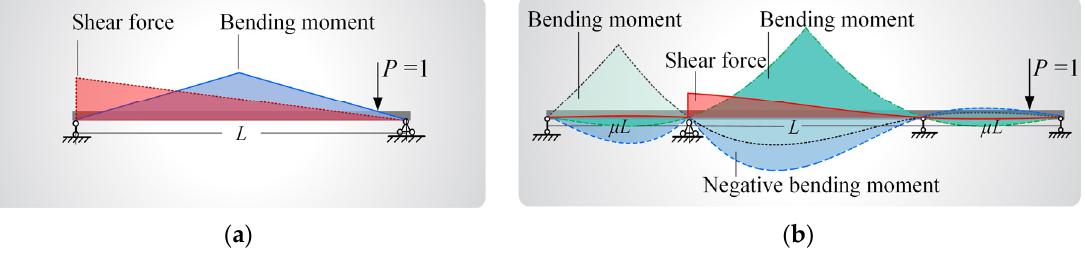
Figure 5. Influence lines for internal forces of ( a ) a simply supported bridge and ( b ) a continuous bridge.